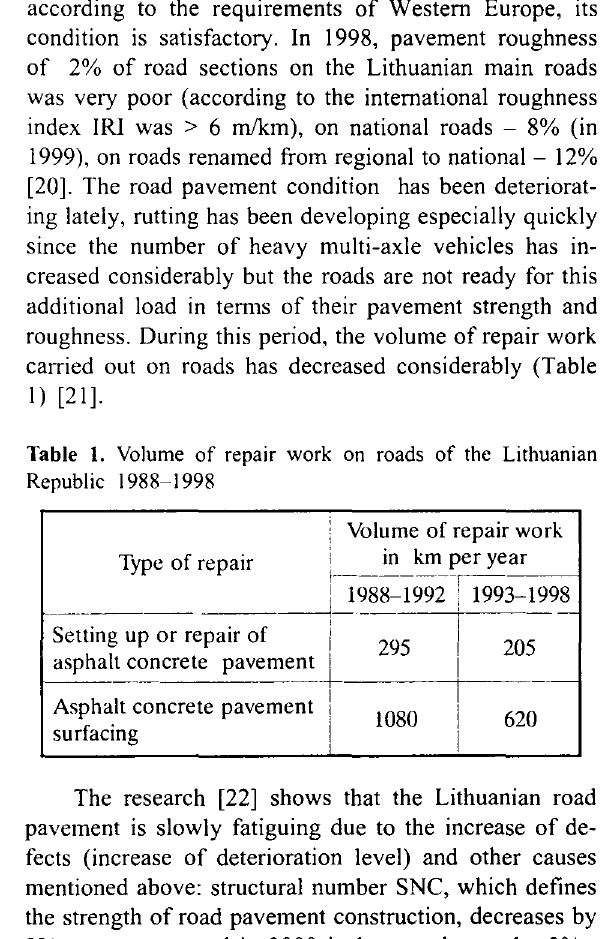
Table l. Volume of repair work on roads of the Lithuanian Republic I 988-I 998